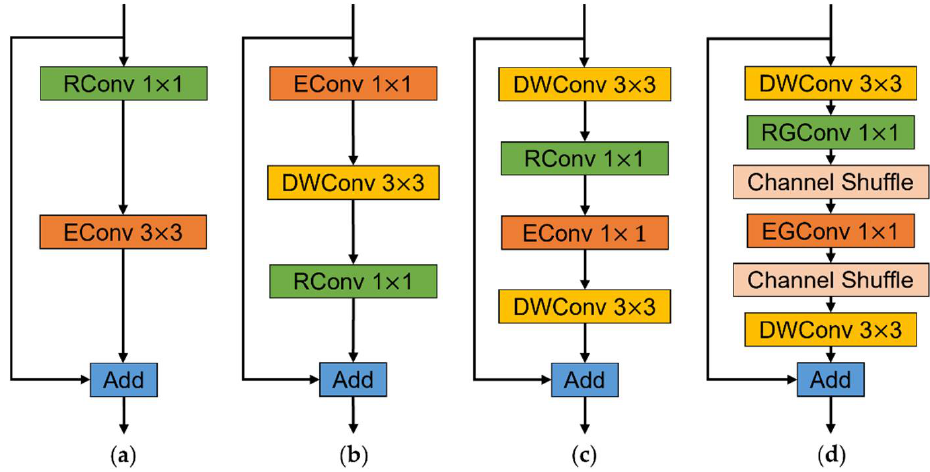
Figure 3. The residual blocks mentioned in this paper: ( a ) classic residual block; ( b ) inverted residual block; ( c ) sandglass block; and ( d ) LightSandGlass, proposed in this study.